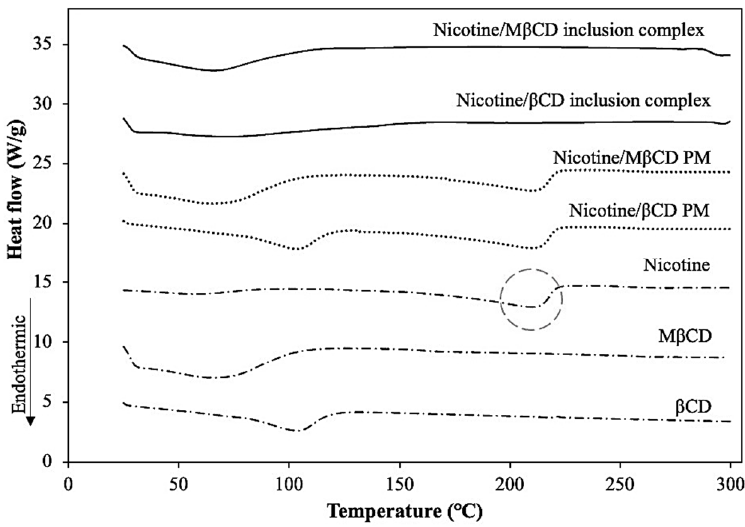
Figure 6. DSC curves of inclusion complexes nicotine/M β CD, nicotine/ β CD, PMs, nicotine, M β CD, and β CD.